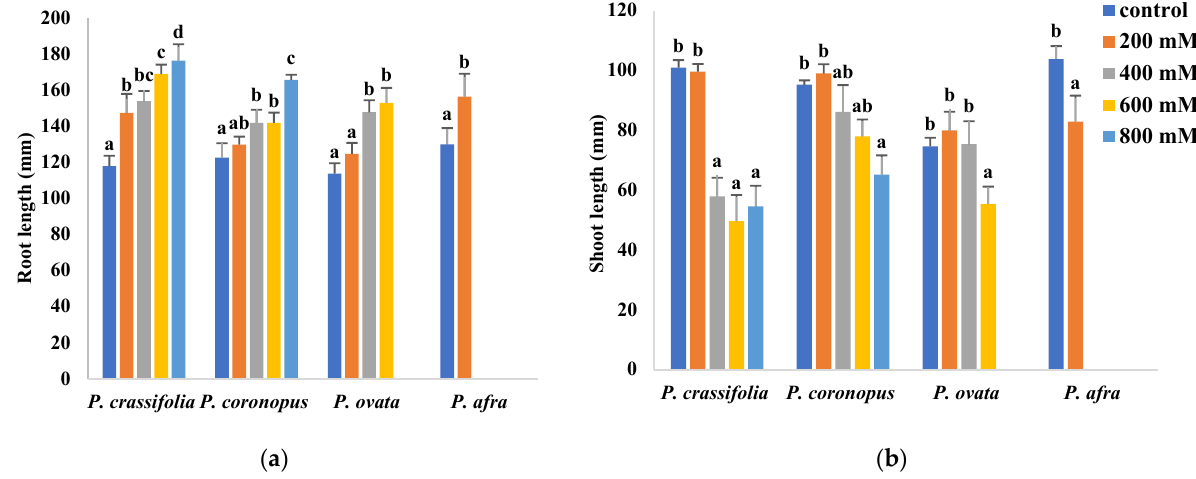
Figure 1. Root length ( a ) and shoot length ( b ) of the four selected Plantago species after four weeks of treatment with the indicated NaCl concentrations. The values shown are means ± SE ( n = 5). For each species, different letters over the bars indicate significant differences between treatments, according to the Tukey test ( p < 0.5).